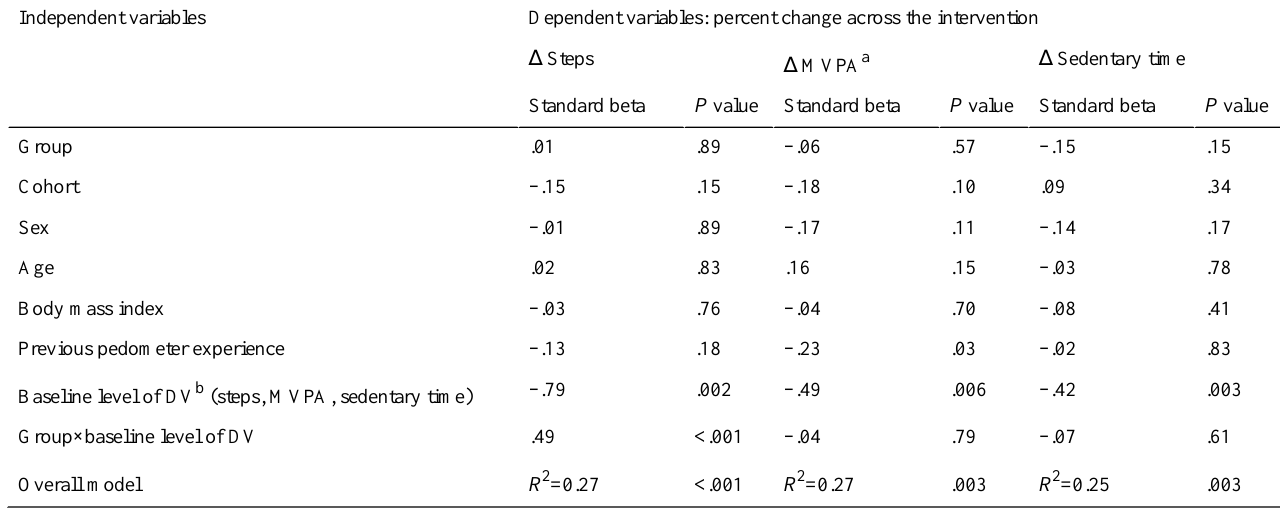
Table 3. Results from the regressions examining predictors of change in active and sedentary time measured using ActiGraph and activPAL monitors.